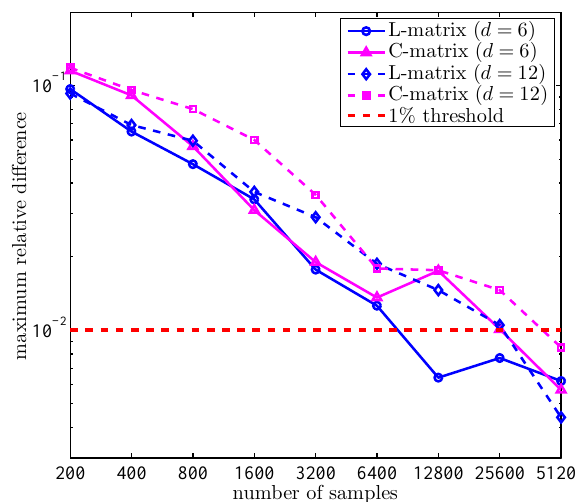
Table 4: Simulation times and accuracy for the shielded cable analysis.